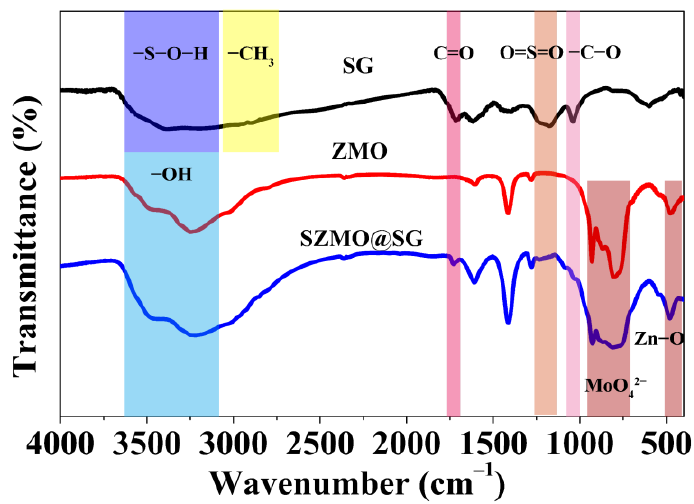
Figure 2. FT-IR spectra of SG, ZMO, and SZMO@SG.